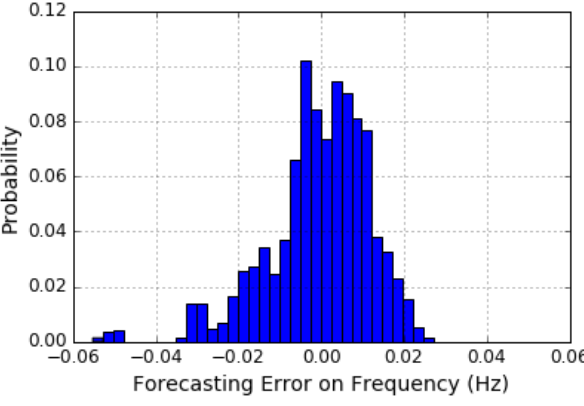
Figure 14. Distribution of f